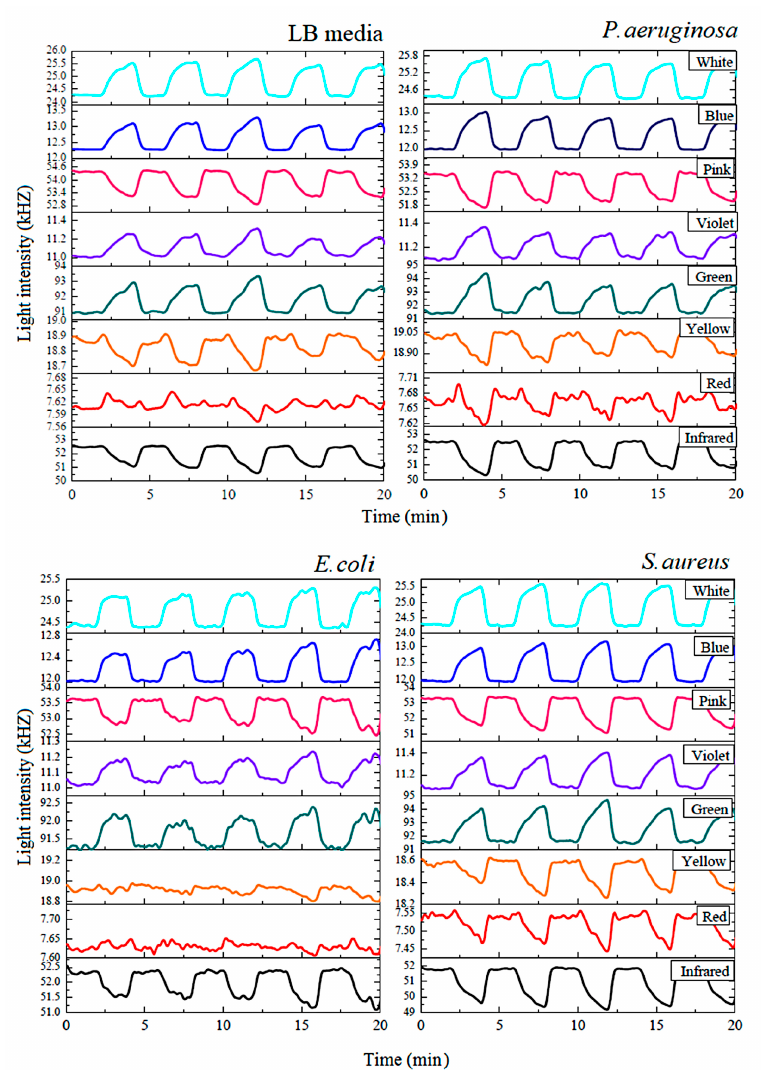
Figure 7. The gas sensing signal of the thermally treated gas sensor with Luria-Bertani (LB) media and the three types of bacteria as measured by the in-house, optical artificial nose.